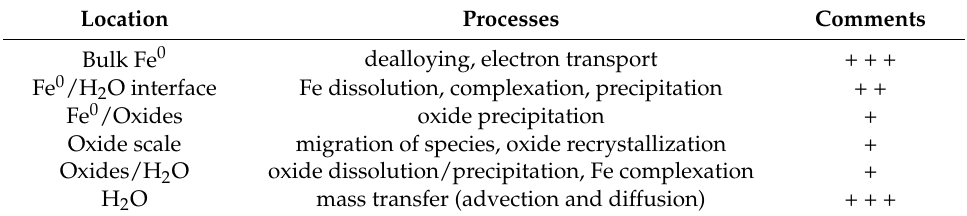
Table 1. Some relevant processes occurring in the elemental iron (Fe 0 )/H 2 O system and their spatial locations. The comments relate to the extent to which each process has been considered in the Fe 0 literature, with “+ + +” denoting being regarded as satisfactorily, and “+” just acknowledged. Location